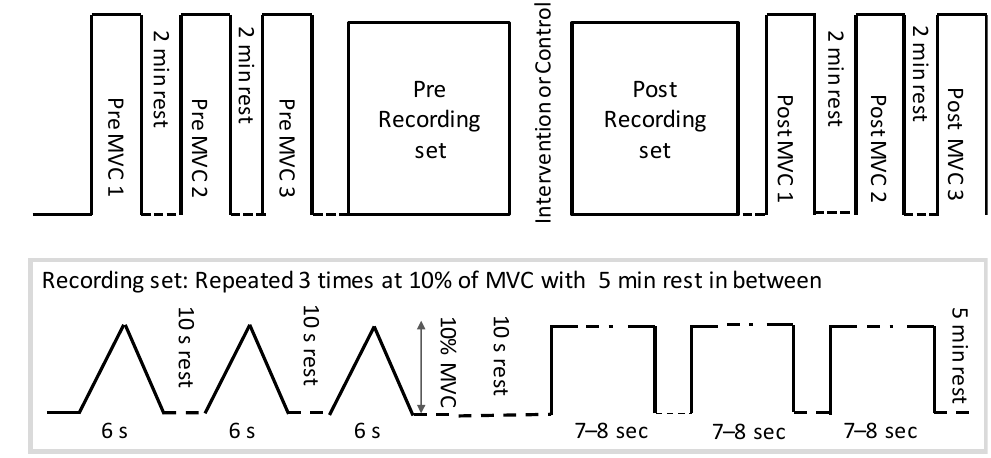
Figure 1. The protocol followed by each participant. MVC = maximum voluntary contractions.